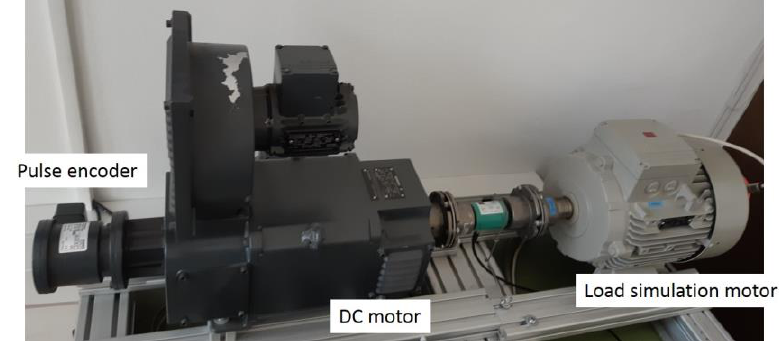
Figure 5. Drive used for measurements.